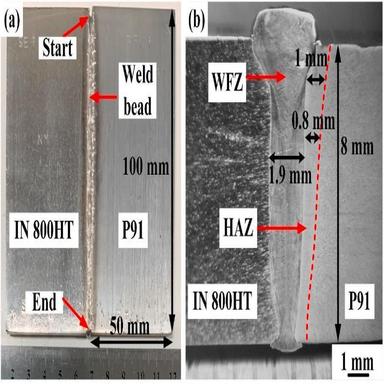
(a) Electron beam welded plate in AW state; (b) macrostructure of weld seam in AW state.